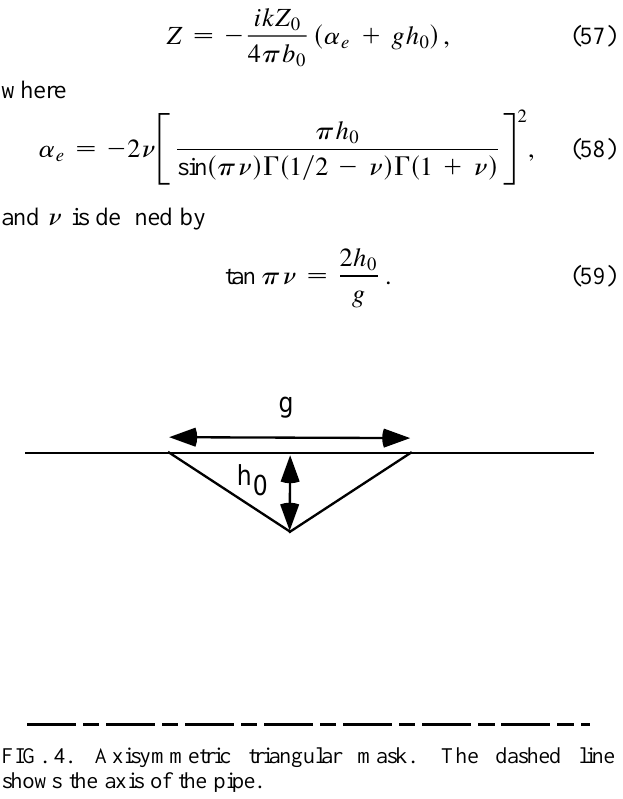
FIG. 4. Axisymmetric triangular mask. The dashed line shows the axis of the